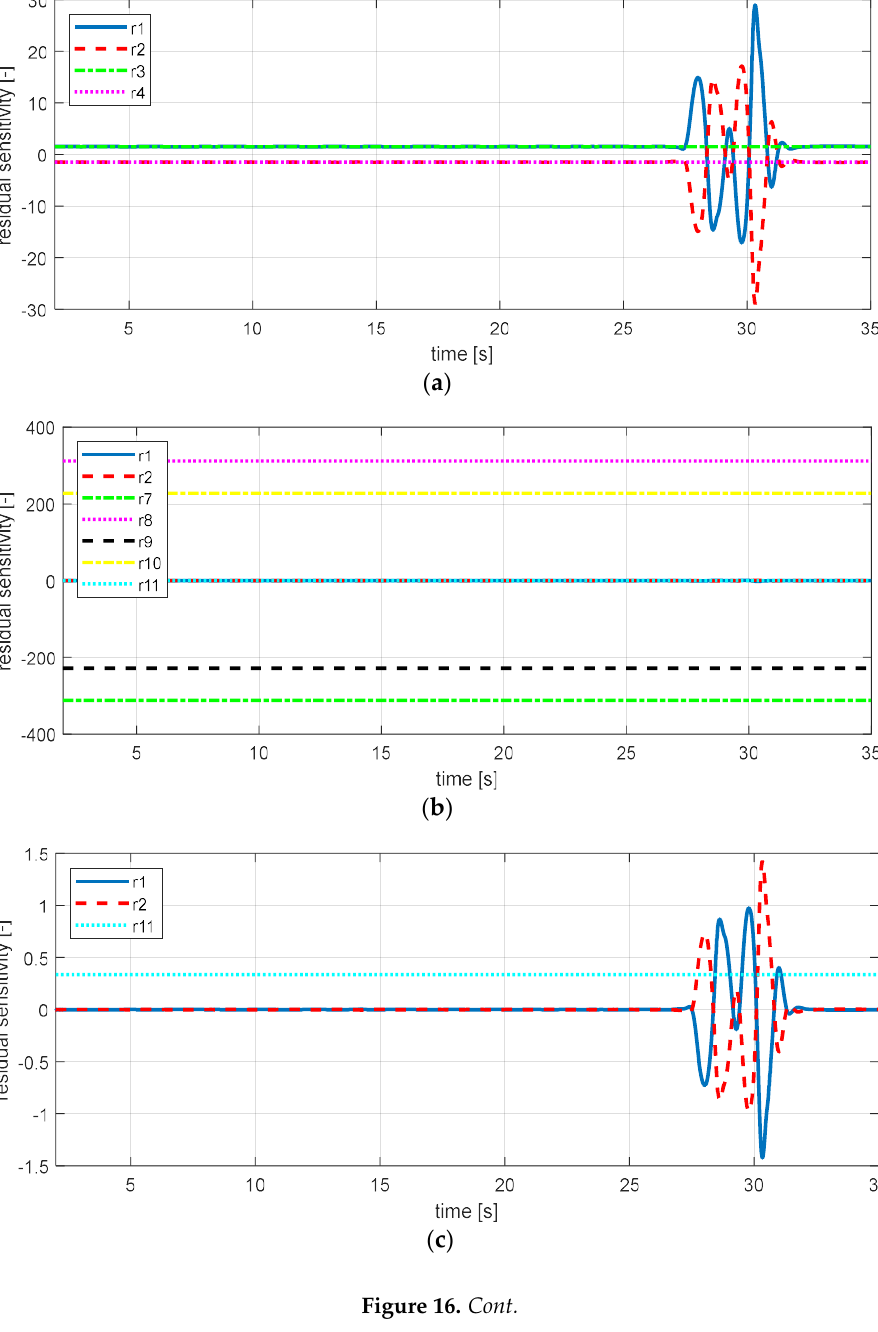
( d ) ( e ) Figure 16. Sensitivity simulation result. ( a ) The sensitivity of yaw rate (residuals 1–4); ( b ) sensitivity of lateral acceleration (residuals 1, 2, 7, 8, 9, 10, 11); ( c ) sensitivity of lateral acceleration (residuals 1, 2, 11); ( d ) sensitivity of wheel angular speed—fl (residuals 1, 5); ( e ) sensitivity of body vertical acceleration—fl (residuals 1, 5). Table 7. Fault detection and isolation table. 𝝋̇